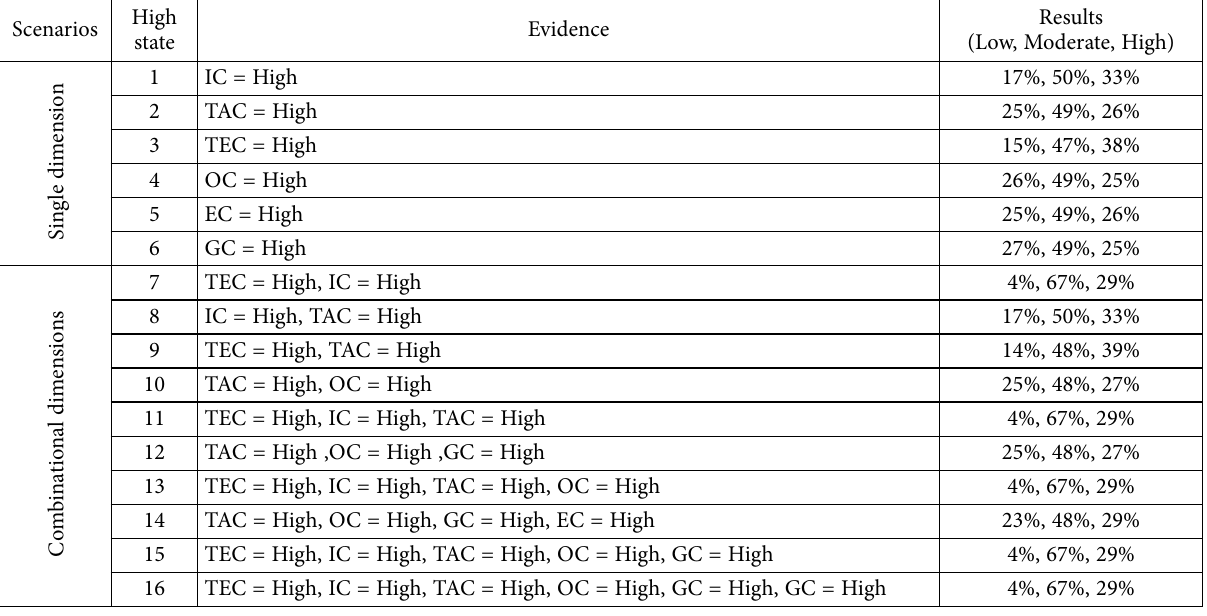
Table 4. Results of the predictive analysis under different scenarios High Scenarios state